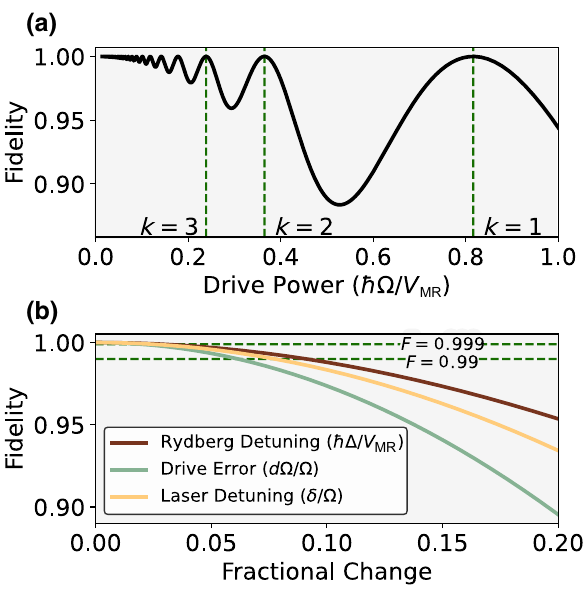
FIG. 3. (a) Demonstration of driven exchange resonances at various integer k , as defined in Eq. (7). As k increases, the res- onances become closer and shallower, leading to insensitivity to the exact drive Rabi frequency. (b) Fidelity loss due to fractional errors in detuning and drive Rabi frequency for k = 1. In this figure, d (cid:7) refers to the error in the Rabi frequency of the driving laser.